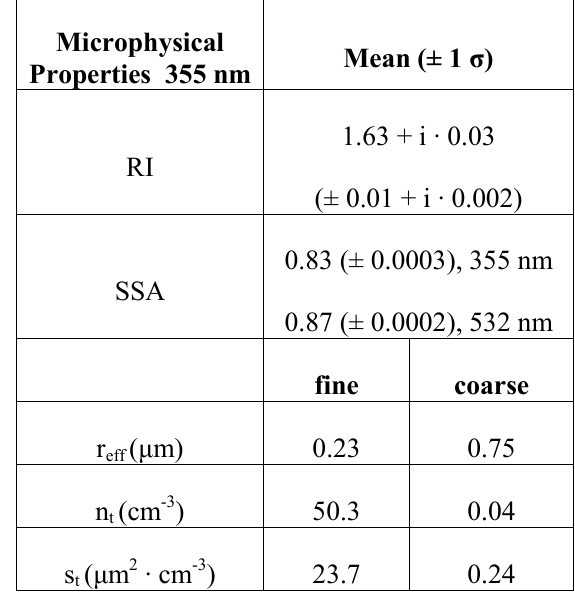
Table 1: Aerosol preliminary microphysical properties for the fine and coarse aerosol